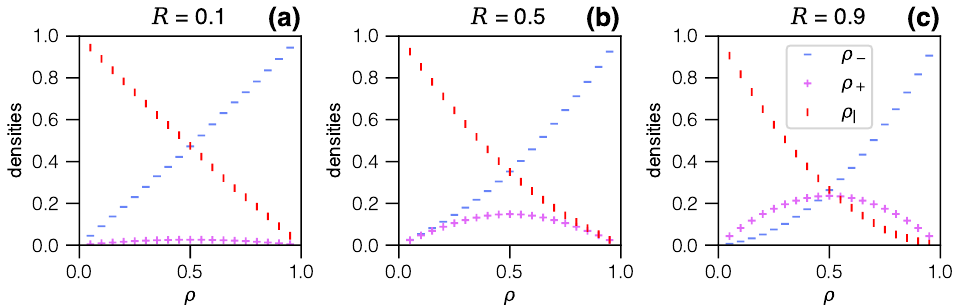
Figure 4: Plots of the partial densities of expanded particles ( ρ + ), compressed par- ticles ( ρ − ) and empty sites ( ρ | ) as a function of the overall particle density ρ , for different values of R : (a) expansion-limited regime, (b) intermediate regime and (c) fast